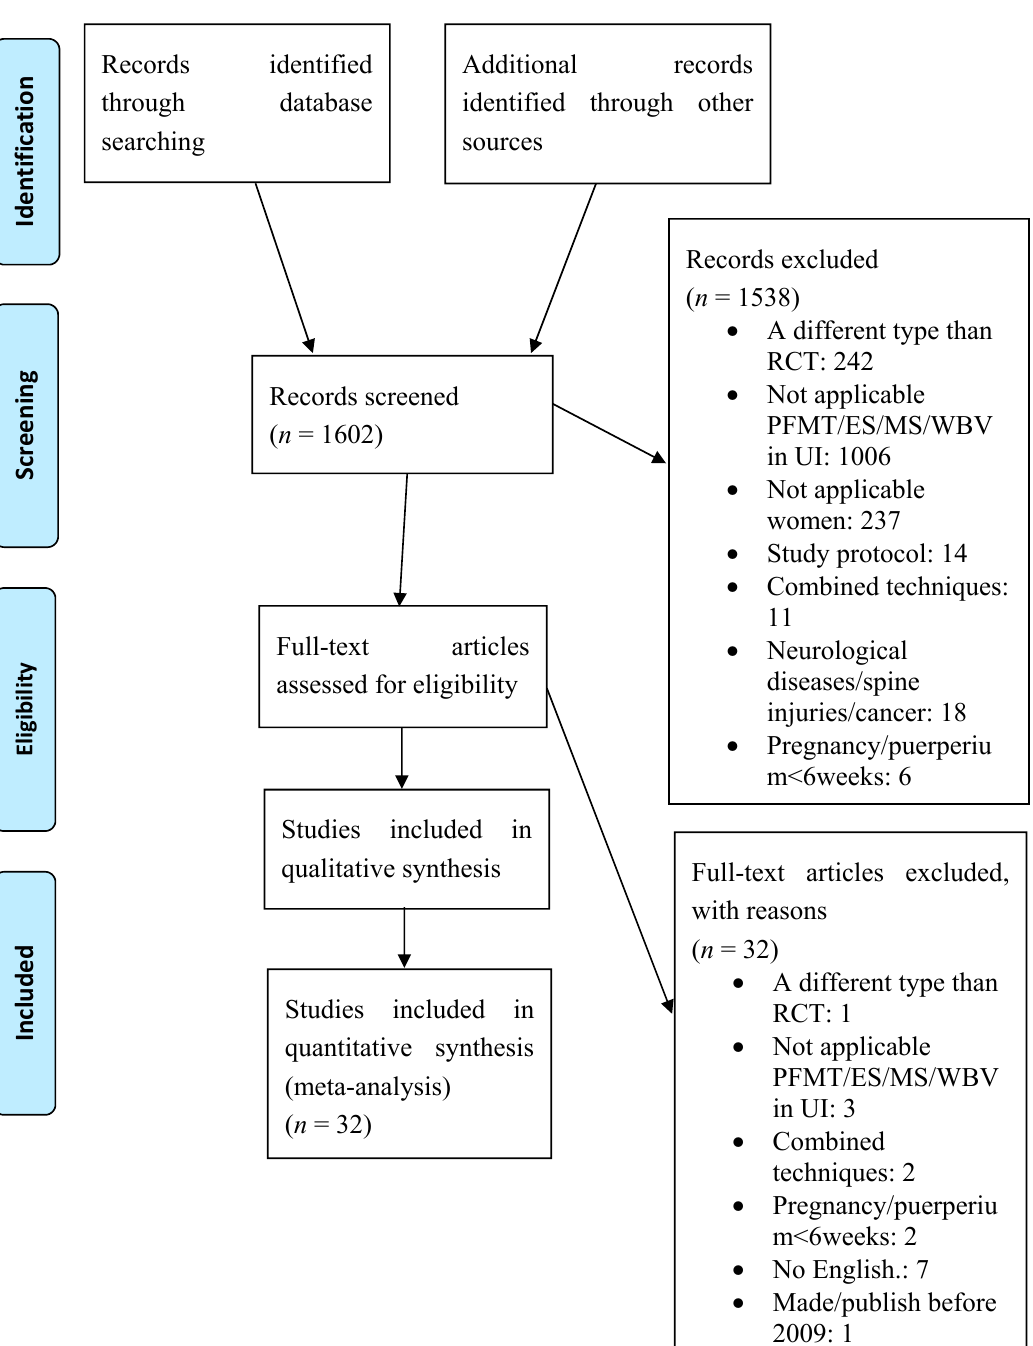
Figure 1. A diagram showing the stages of the literature review (2009 PRISMA flow